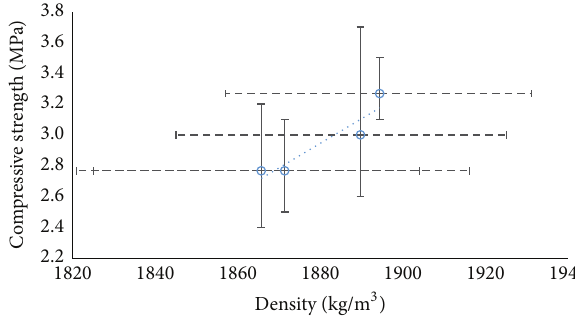
Figure 9: Correlation between compressive strength and